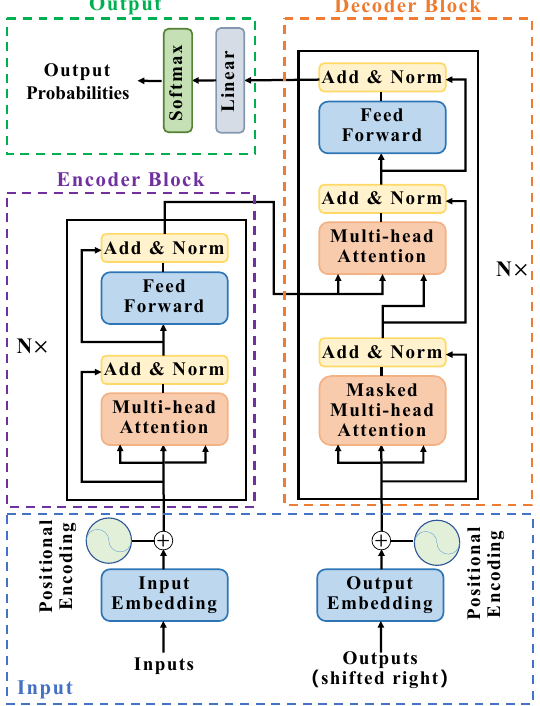
Figure 2. Transformer network structure diagram.